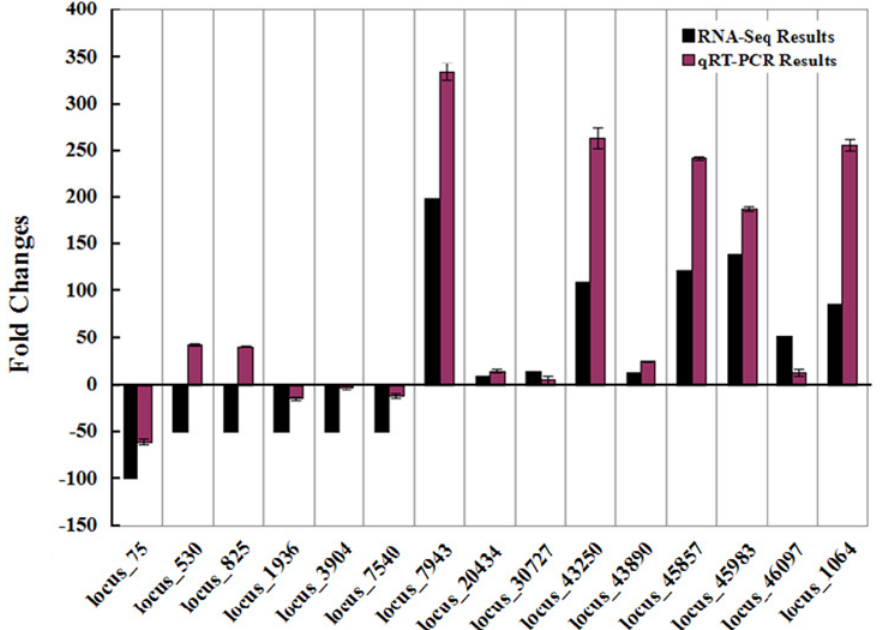
Fig 9. Verification of the RNA-seq results by qRT-PCR. The top ten up-regulated and five down-regulated transcripts were selected for verification by qRT-PCR. The X-axis shows the fifteen locuses and the Y-axis stands for the fold changes of the transcripts. The black bar stands for the results of RNA-seq and the red bar represents the outcomes of the qRT-PCR. The results of the qRT-PCR are mean standard deviations ( ± SD) of three replicates at